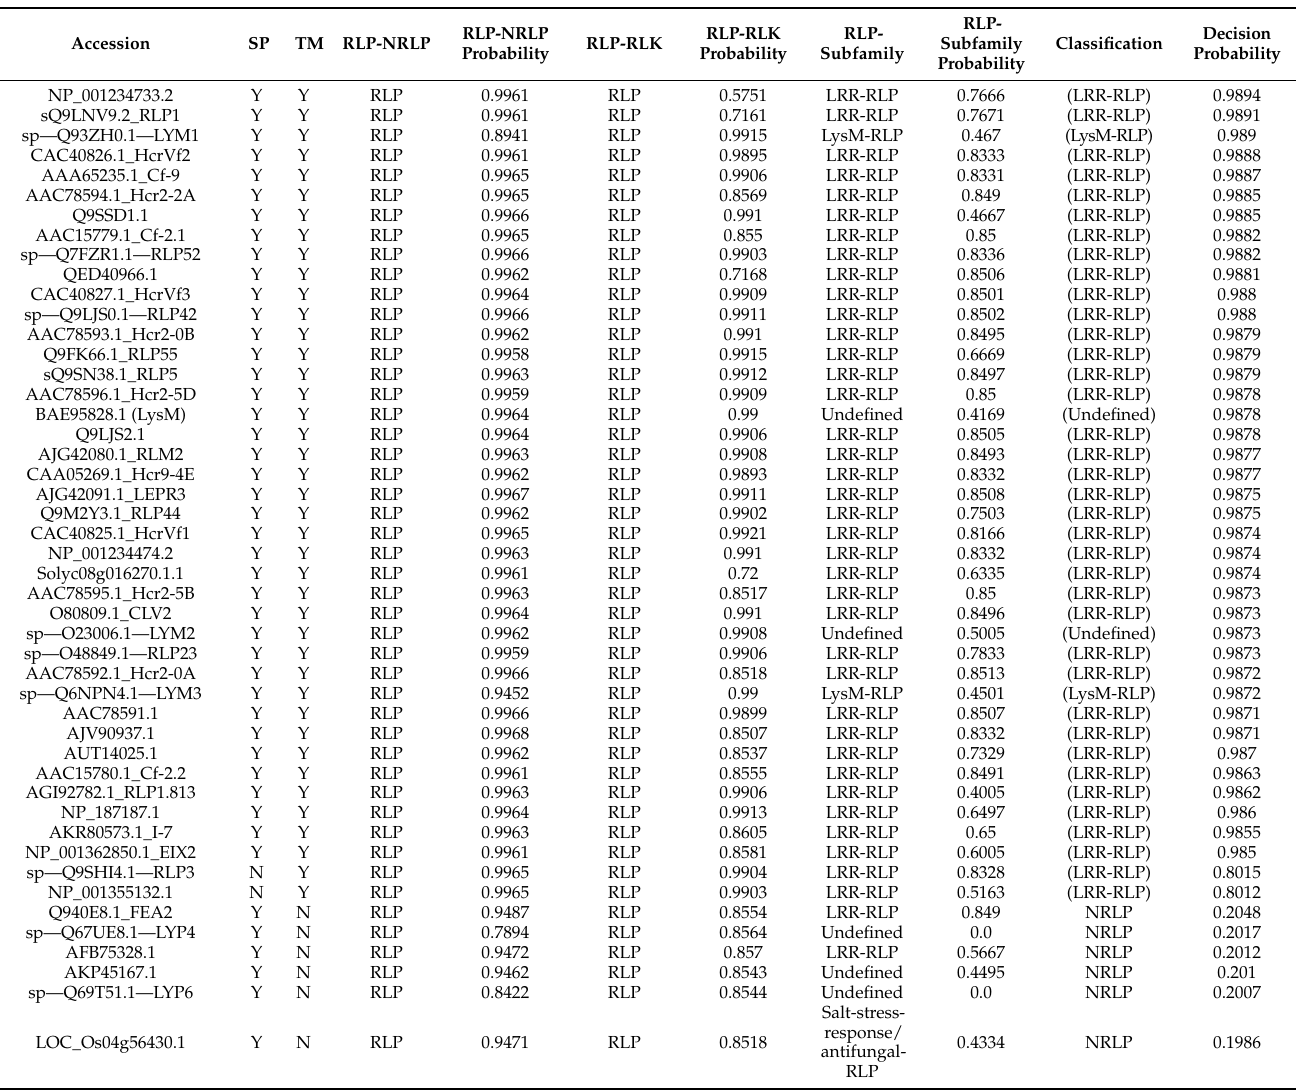
Table 6. Validation of the almost characterized